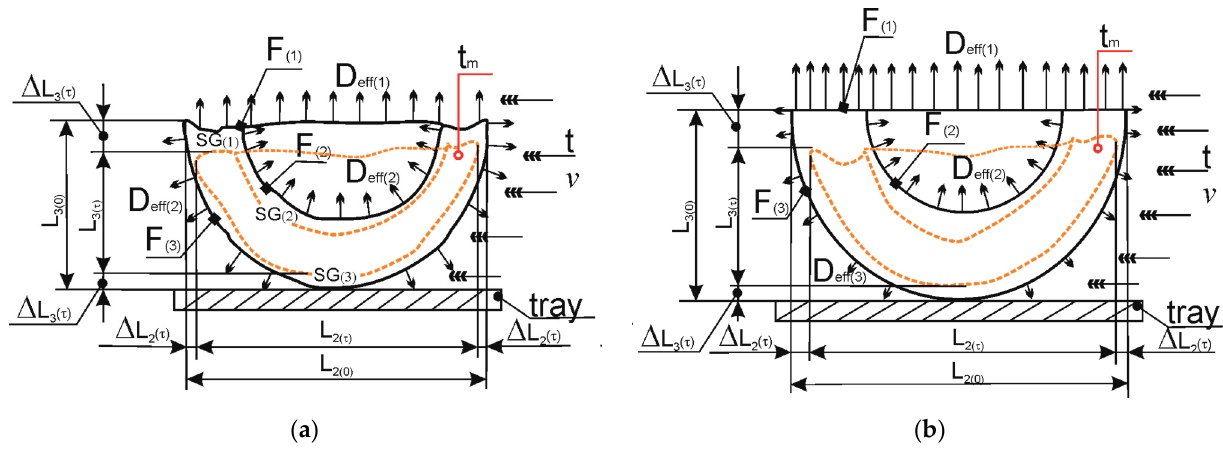
Figure 8. Cross-section of the apricot halves with shrinkage and mass transfer during osmotic dehydration: ( a ) Water loss (WL); ( b ) Solid gain (SG). F (1) —Surface after cutting; F (2) —Surface after the stone was removed; F (3) —Surface; L 2(0) , L 2( τ ) —Width of apricot half at the beginning of process and at time τ ; L 3(0) , L 3( τ ) —Thickness of apricot half at the beginning of process and at time τ ; WL (1) , WL (2) , WL (3) —Water loss through surfaces F( 1 ), F( 2 ), F( 3 ); SG (1) , SG (2) , SG (3) —solid gain through surfaces F( 1 ), F( 2 ), F( 3 ); Δ —difference; → direction of water and solute diffusion, ▪▪▪▪ —dash line dimensions after OD.